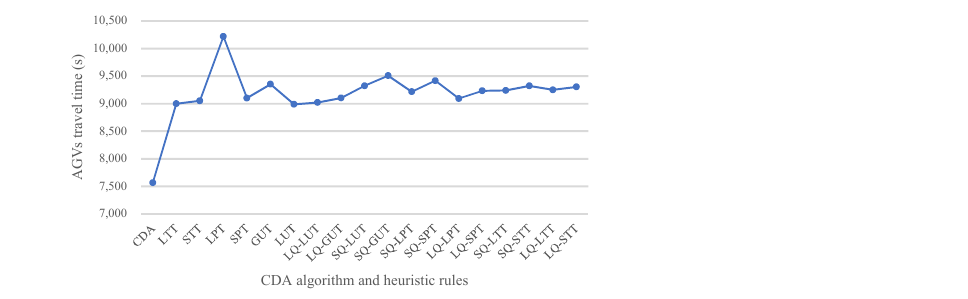
Figure A3. Curve of AGVs travel time of CDA algorithm and assignment rules under different cases.